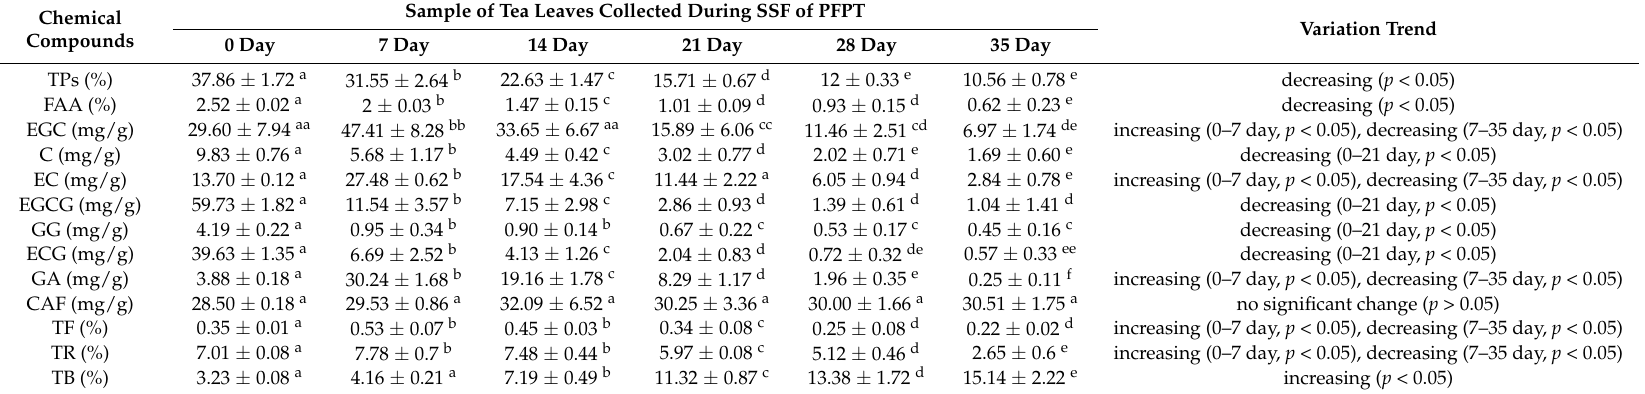
Table 1. Variation of levels of chemical compounds during solid-state fermentation (SSF) of Post-fermented Pu-erh tea (Pu-erh Shucha, PFPT). Sample of Tea Leaves Collected During SSF of Chemical Compounds